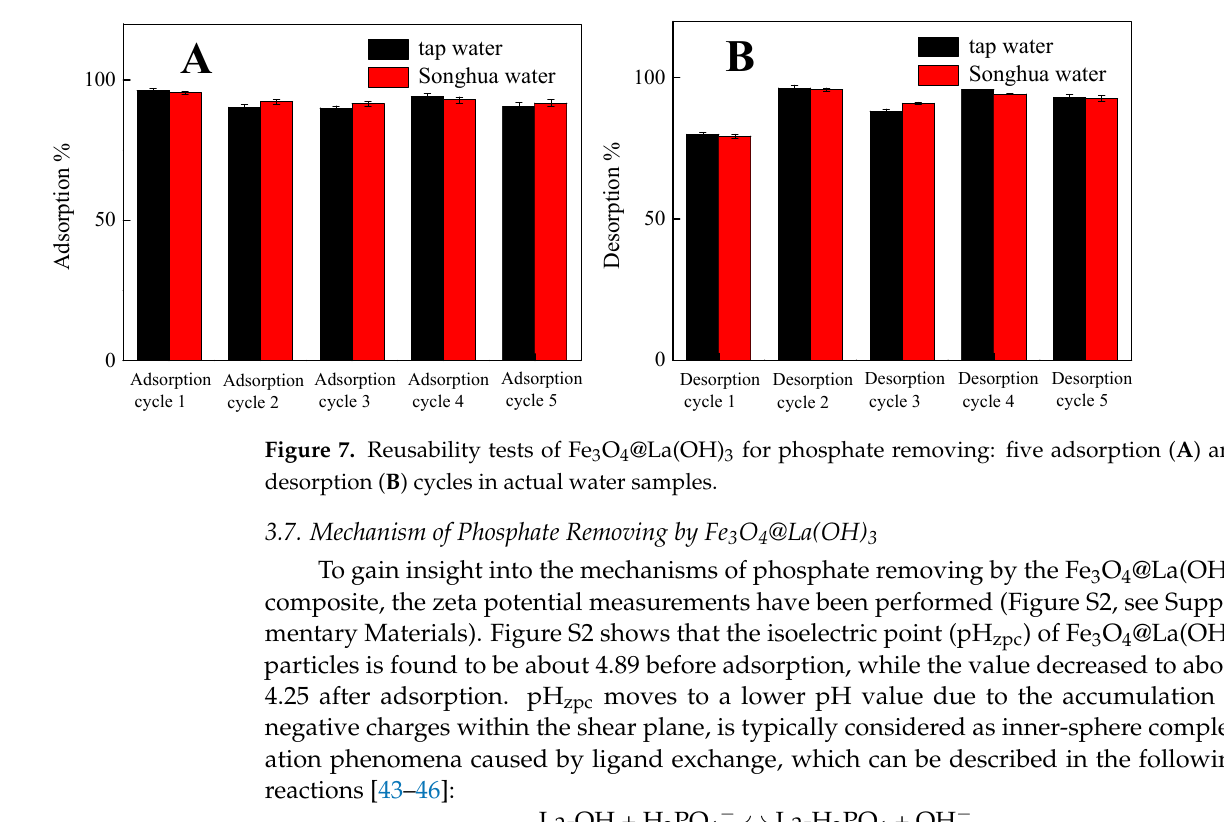
11 of 14 Table 2. Freundlich and Langmuir constants and correlation coefficients for adsorption of phos- phate onto Fe 3 O 4 @La(OH) 3 . Temperature (K)